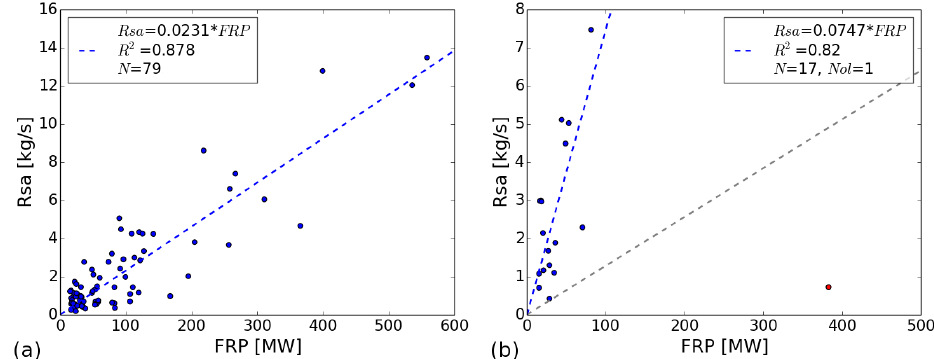
Figure 3. Scatter plots of smoke emission rate ( R sa ) against fire radiative power (FRP or R fre ) derived from both Terra and Aqua MODIS observations during the period 2003–2010 for a 1 ◦ × 1 ◦ grid cell centered at (a) 1.5 ◦ S, 15.5 ◦ E, and (b) 22.5 ◦ N, 115.5 ◦ E. The latter demonstrates the effect of removing outliers in such scatter plots. The outlier is identified in red and the blue line is the linear least-squares regression fit through the remaining points, which in this case results in a C e value of 0.0747 and an r 2 value of 0.82. This is a great increase over the case without the outlier removal process, whose regression line is shown in gray and has much lower values of both C e (0.0128) and level of confidence ( r 2 = 0 .